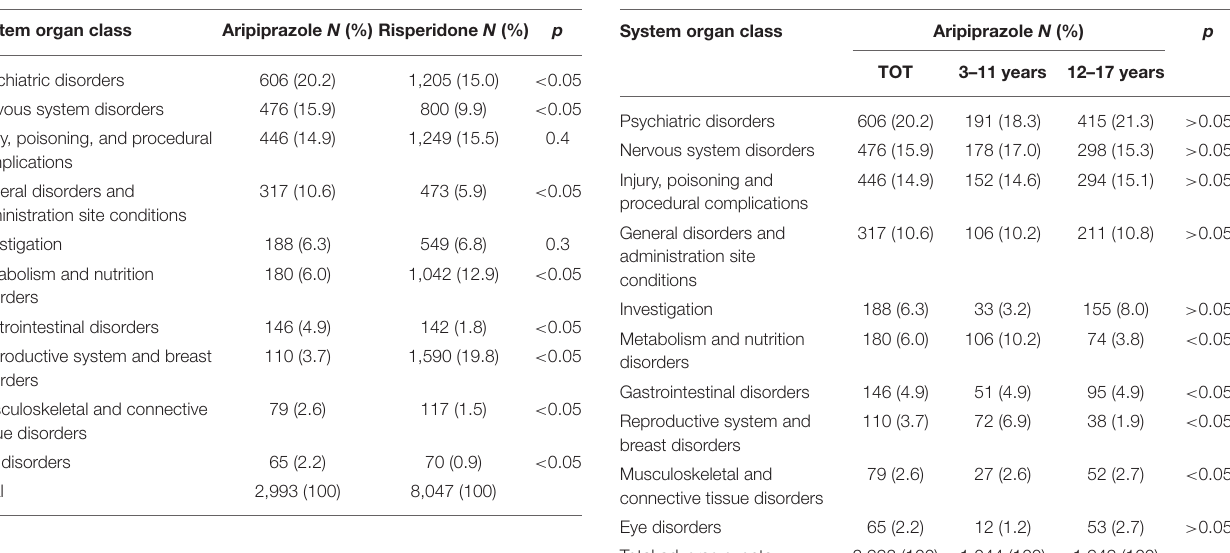
TABLE 5 | Distribution of adverse drug events (AEs) categorized according to the system organ classes (SOCs) and involving aripiprazole as a suspected